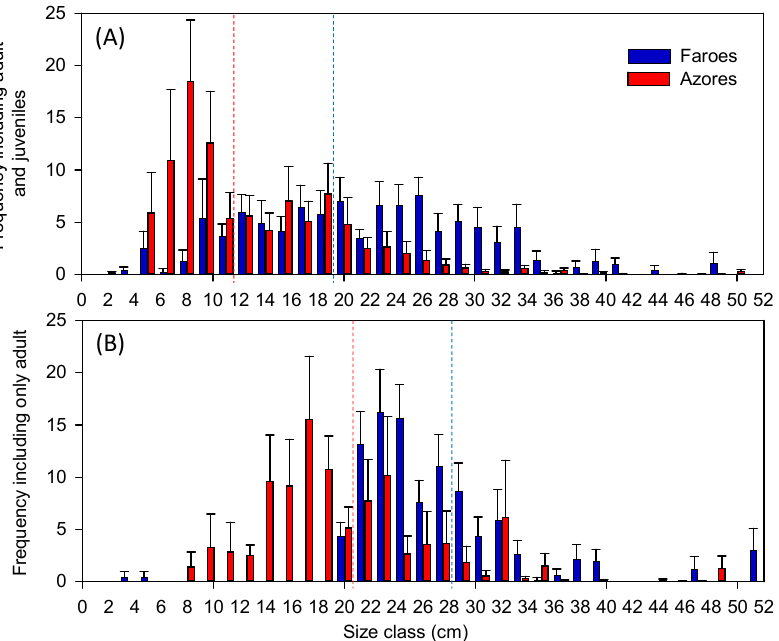
Figure 4. Size frequency (cm) of the fish assemblages in each lake from the Azores (red) and the Faroe Islands (blue), in each region, including both adults and juveniles ( A ), and including only adults ( B ), dotted lines represent the median, deviation bars represent SE.